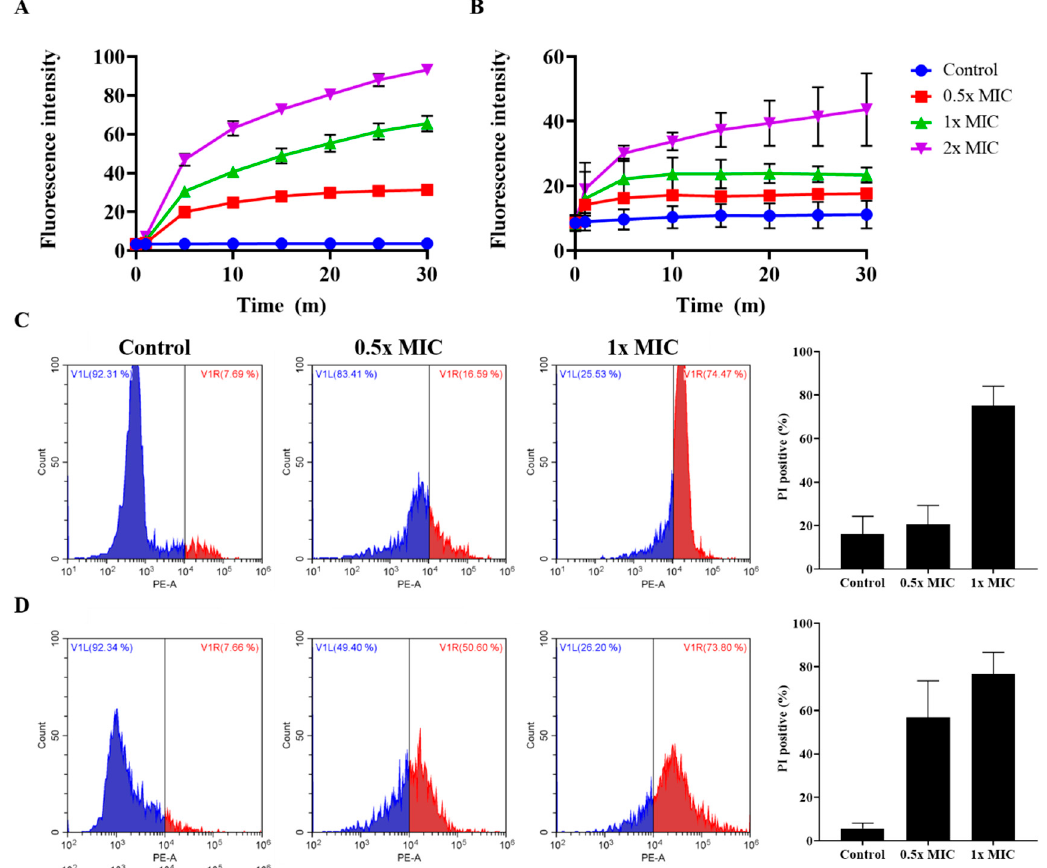
Figure 7. Analysis of L. monocytogenes and S. typhimurium membrane integrity after treatment with Css54. Css54 at 0.5 × , 1 × , and 2 × MIC were added to ( A ) S. typhimurium and ( B ) L. monocytogenes . Fluorescence intensity of SYTOX green was measured at emission and excitation wavelengths of 520 and 485 nm, respectively. Flow cytometry analysis using propidium iodide staining against bacterial membrane integrity. Changes in ( C ) S. typhimurium and ( D ) L. monocytogenes after treatment with peptide at 0.5 × and 1 × MIC for 10 min were measured by flow cytometry using propidium iodide (PI).